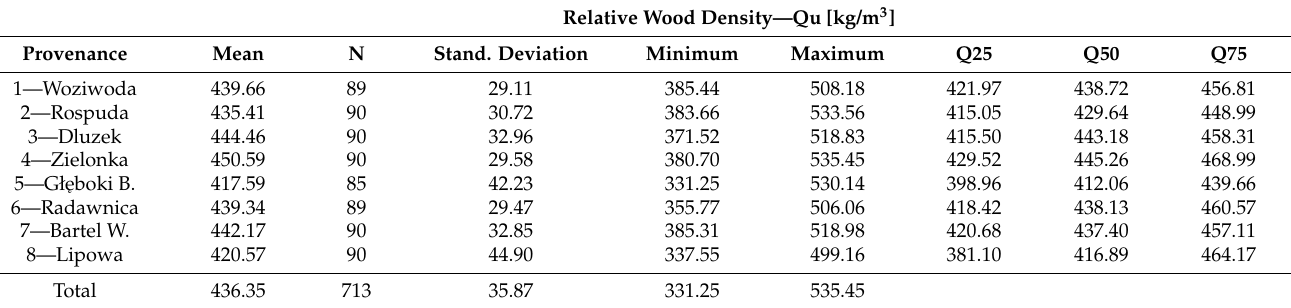
Table 2. Statistics of relative wood density for the compared Scots pine ( Pinus sylvestris L.)